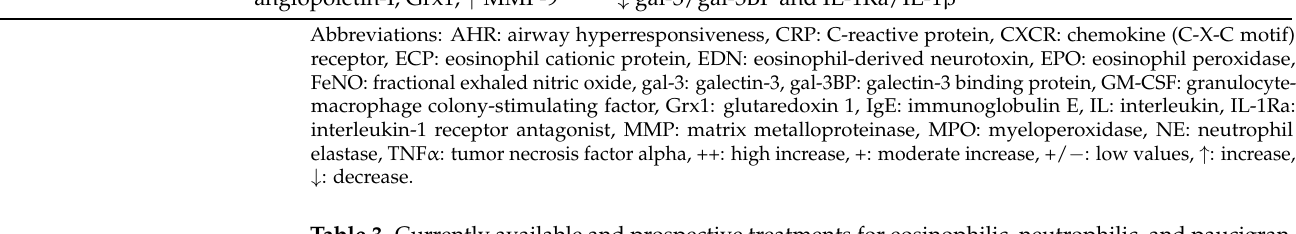
Table 3. Currently available and prospective treatments for eosinophilic, neutrophilic, and paucigran- ulocytic endotypes of bronchial